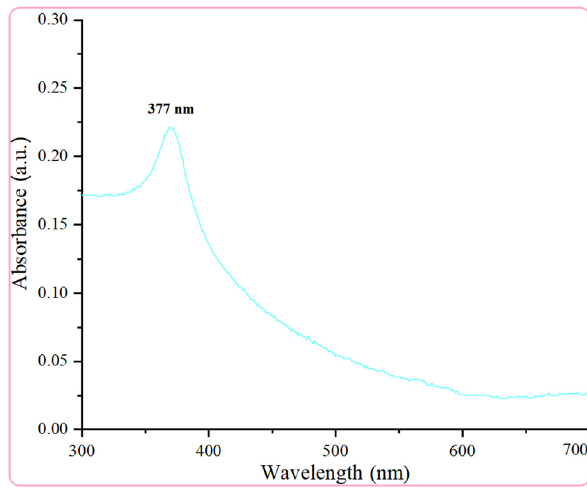
Figure 1: UV - Vis absorption spectra of ZnONPs.